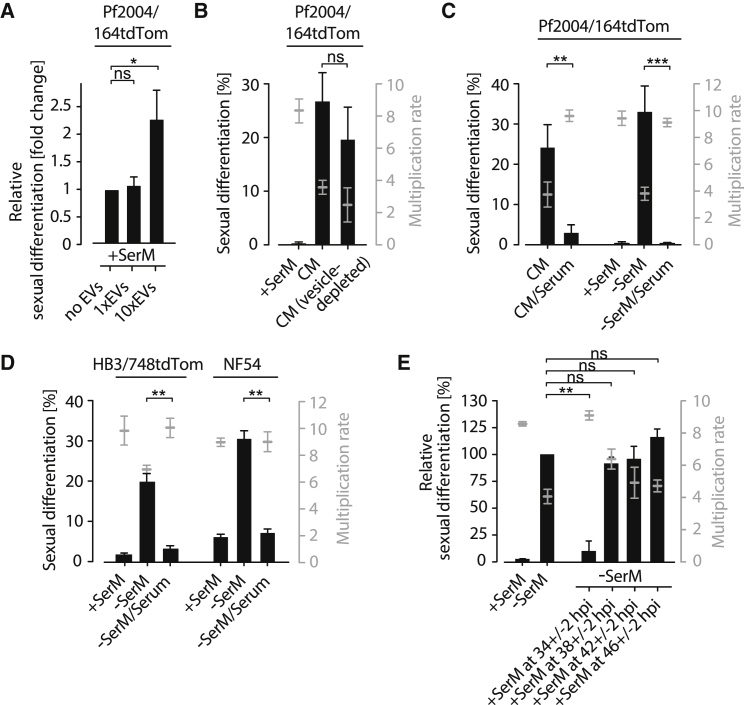
P. falciparum Sexual Commitment Is Subject to Host-Factor Availability(A) EVs induce gametocyte formation at high concentrations. Parasites were challenged with EVs isolated from high-parasitemia cultures at the original (1×) and 10× concentrations. Bars show fold change of sexual differentiation normalized to the untreated (no EVs) condition. Absolute differentiation rates were generally low (average of 0.41% in “no EVs” and 1.12% in “10xEVs” condition). n = 3, standard deviations are shown; ns, not significant; ∗ p < 0.05, Student’s t test. Parasites of strain Pf2004 were used (transfected with reporter plasmid 164tdTom [Pf2004/164tdTom]).(B) Conditioned medium induces sexual commitment independently of parasite-derived vesicles. +SerM, serum-supplemented medium; CM, conditioned medium. Bars show sexual differentiation rates (left axis). Effect on parasite growth is indicated (right axis). n = 3; standard deviations are shown; ns, not significant, Student’s t test.(C) Parasites induce sexual differentiation in response to serum depletion in −SerM conditions. n = 3, standard deviations are shown, ∗∗ p < 0.01, ∗∗∗ p < 0.001, Student’s t test. CM, conditioned medium; “/Serum” indicates supplementation with 10% serum.(D) Serum depletion induces sexual commitment across different P. falciparum strains. n = 3, standard deviations are shown, ∗∗ p<0.01, Student’s t test. Parasites of strain HB3 (transfected with reporter plasmid 748tdTom [HB3/748tdTom]) and wild-type parasites of strain NF54 were used.(E) Sexual differentiation is irreversibly determined after 38 ± 2 hpi. Except for the +SerM control, all cultures were exposed to −SerM at 28 ± 2 hpi. −SerM was exchanged by +SerM at indicated time points. n = 3, standard deviations are shown, ∗∗ p < 0.01; ns, not significant; Student’s t test.